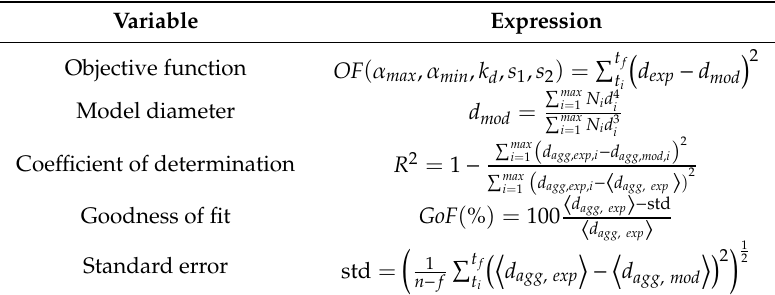
Table 2. Expressions used for PBM optimisation procedure.